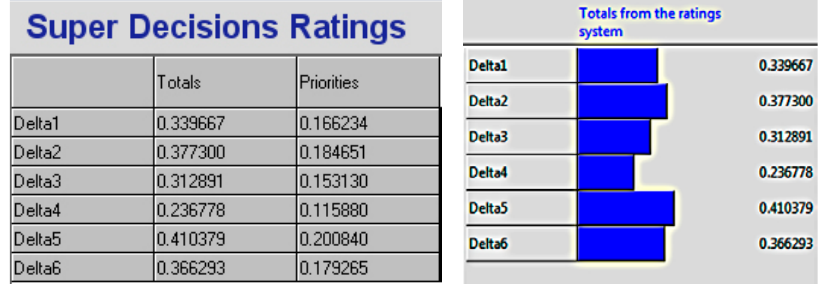
Fig. 6. Ranking of Deltas before sensitivity analysis (weight of CTR